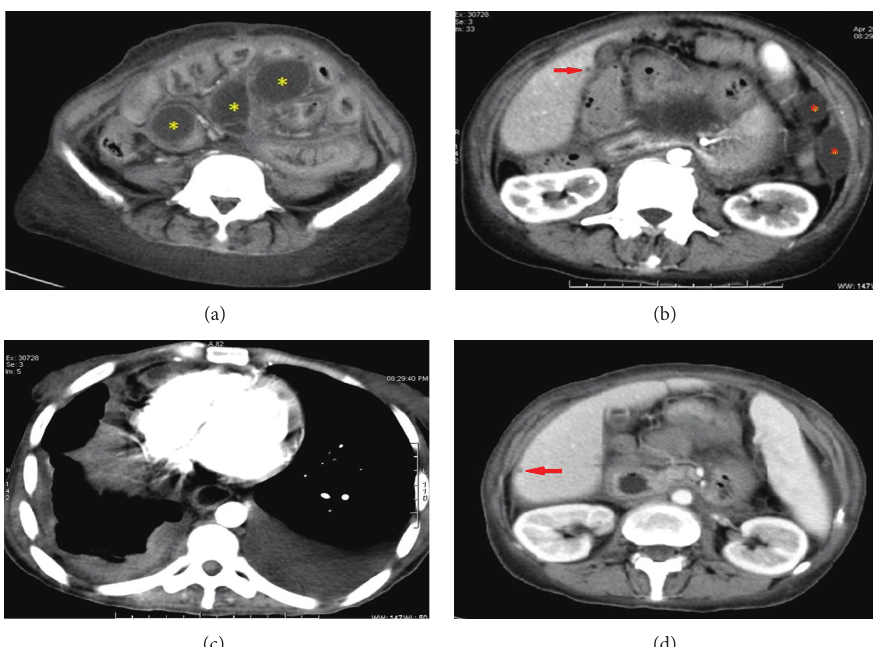
Figure 3: (a) Portal venous phase CT image. Multiple hypodense mesenteric thick walled cystic masses (gold stars) with diffuse intestinal wall thickening. (b) Arterial phase CT image with contrast. Subcentimetric hypodense hepatic focal lesion seen in segment V (red arrows) and two hypodense extraperitoneal cystic lesions seen in left lumbar region (red stars). (c) Bilateral pleural effusions, left side greater than the right. (d) Similar hepatic focal lesion as seen in (b) (red arrow).